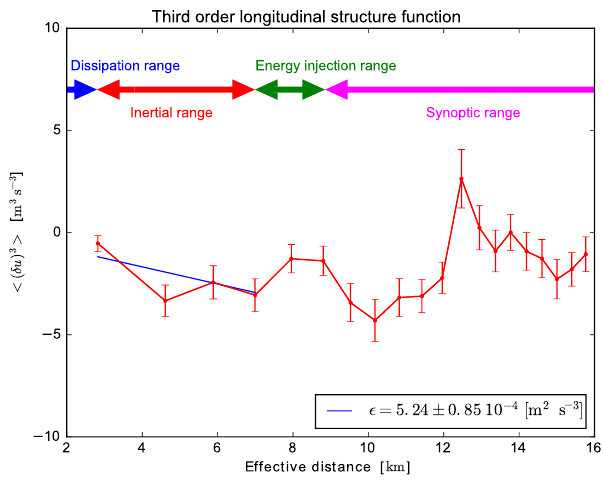
Figure 2. Third order longitudinal structure function for u